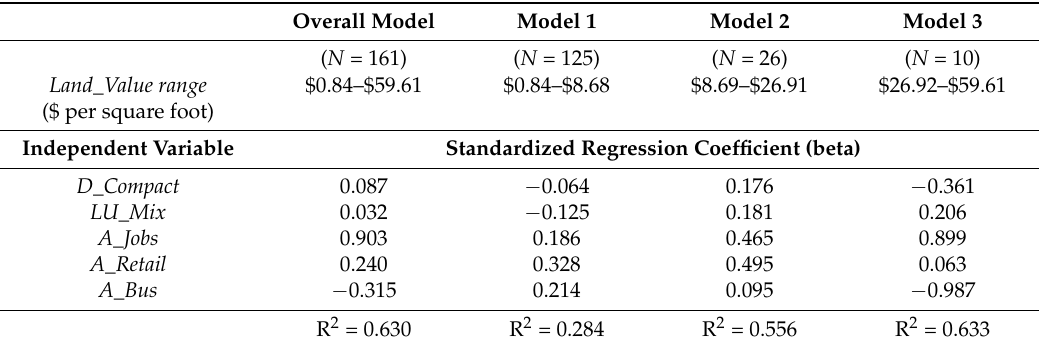
Table 7. Regression results of the overall and three sub-group models.